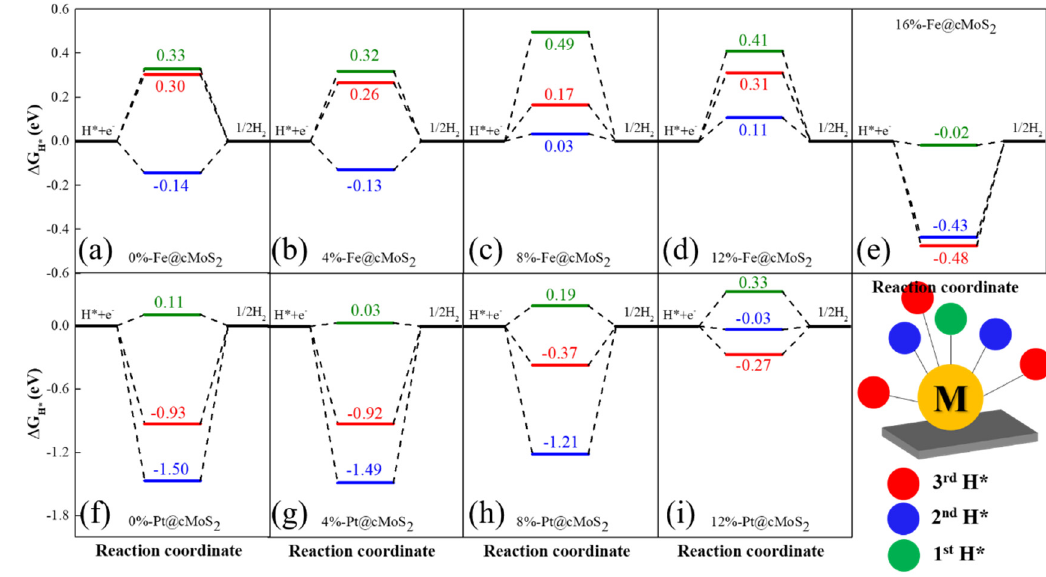
Figure 6. ( a – i ) The free energy diagram of Fe@cMoS 2 and Pt@cMoS 2 for hydrogen evolution reactions at different compressions. The Gibbs free energy of an ideal catalyst for the HER should be close to 0.